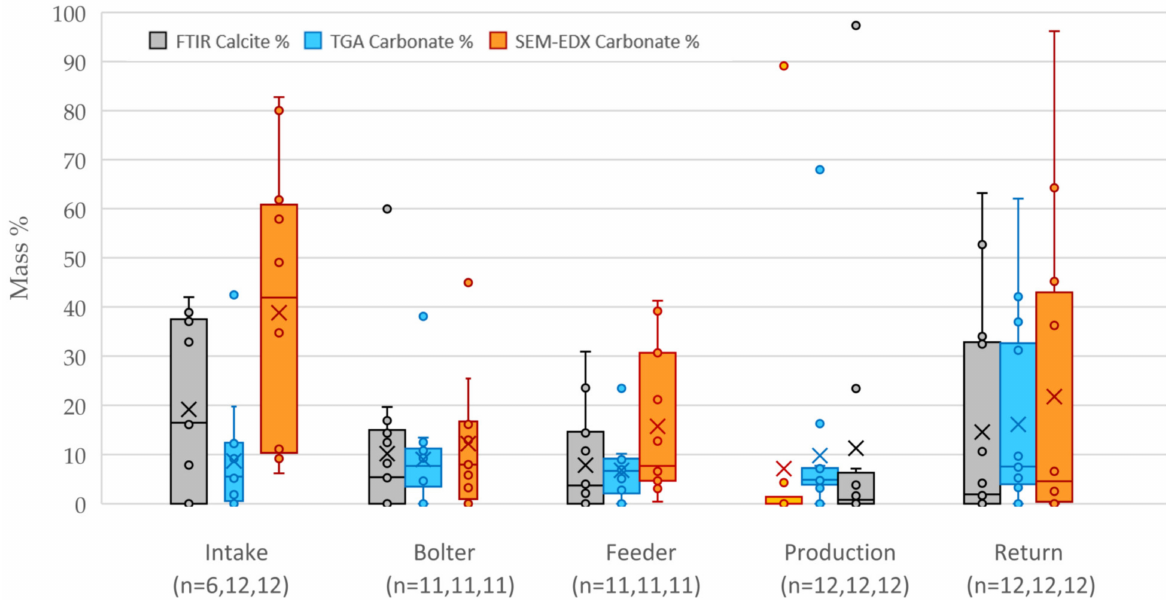
Figure 5. Box and whisker plot showing the FTIR, TGA, and SEM-EDX derived calcite/carbonate mass % for RCMD samples collected in each sampling location (excluding samples from Mines 19 and 20). In some mines, multiple sample sets were collected in a particular location (see Table 1); to avoid biasing results toward these mines, the multiple sample values were averaged to yield a single mine x location value. Thus, n values show the number of data points available for each unique sampling location. Lower, middle, and upper box boundaries show the 25th, 50th, and 75th quartiles, respectively; lower and upper whisker lines show the lowest and highest values, respectively—except the outliers (defined as points 1.5 times the interquartile range away from the box boundaries); circles show the individual data points, and × marks the mean calcite/carbonate mass